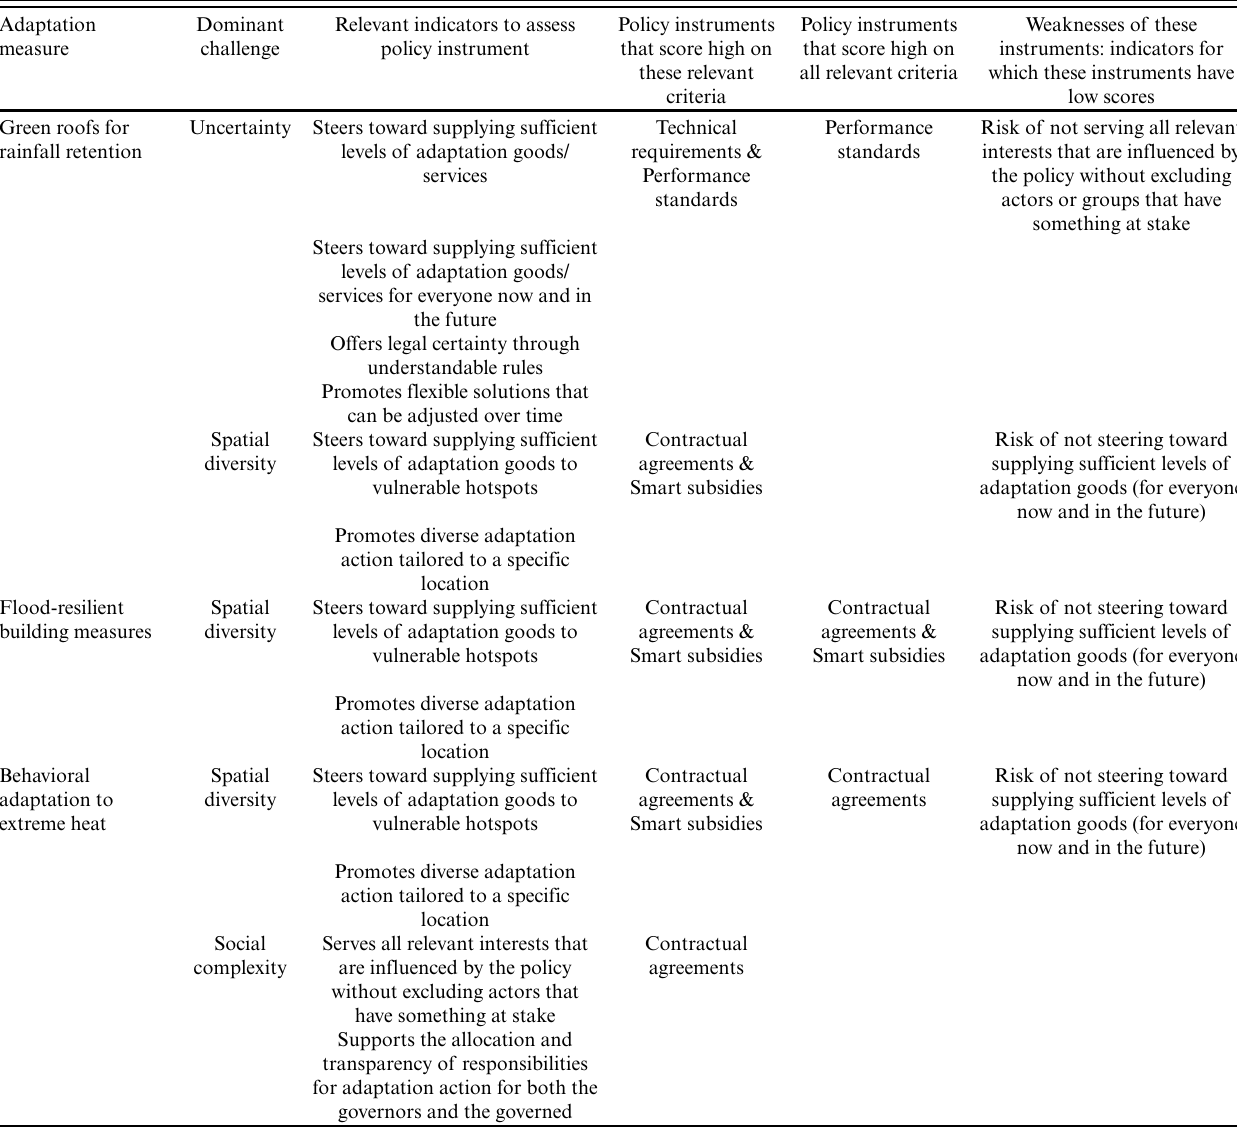
Table 6. Measure-specific assessment of policy